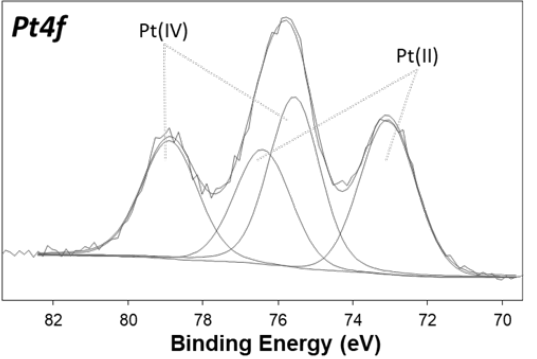
Figure 6. Pt4f XP spectral region of complex 1 along with the curve fitting procedure. Resulting Pt(II) and Pt(IV) signals are